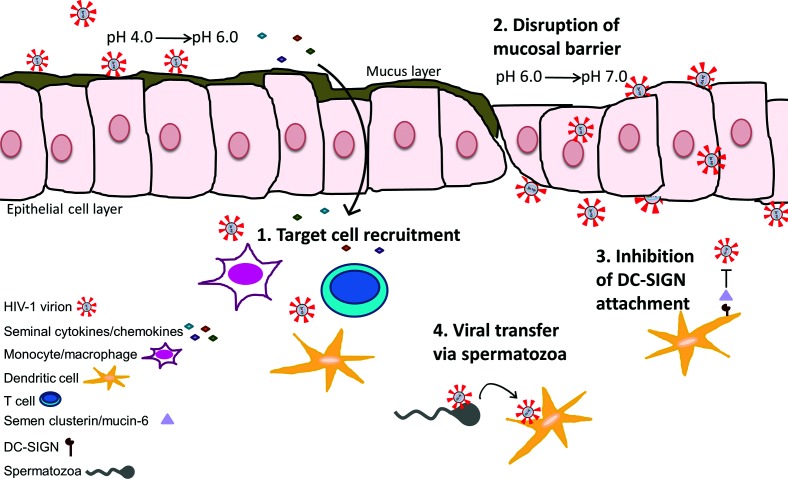
Schematic representation of the effects of semen on the mucosal microenvironment during HIV-1 transmission. (1) Seminal-associated cytokines/chemokines may traverse the mucosal layer and recruit cells susceptible to HIV-1 infection, such as CD4+ T cells, dendritic cells and monocytes or macrophages. (2) The alkaline properties of semen raise the acidic vaginal pH from a range of 4.0–6.0 to one of 6.0–7.0, disrupting the protective mucosal layer and allowing more efficient viral dissemination through the epithelial cell layer. (3) Clusterin and mucin-6 molecules in semen prevent HIV-1 attachment to DC-SIGN on dendritic cells. (4) Spermatozoa may act as carriers of HIV-1 virions to susceptible cells. See text for references.